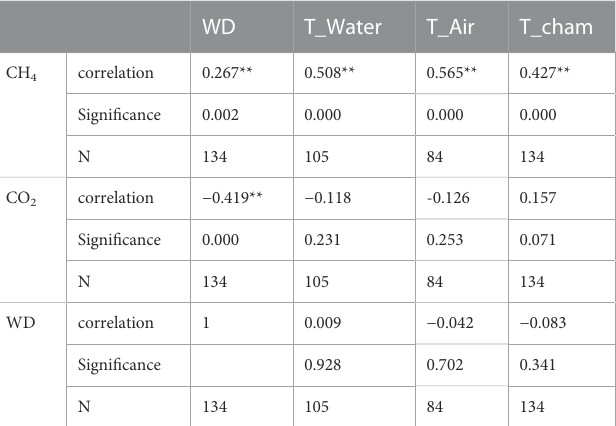
TABLE 1 Correlations of CH 4 andCO 2 with water depthandtemperature, where * and ** showed the signi fi cant dif fi cance at p < .05 and p < .01.